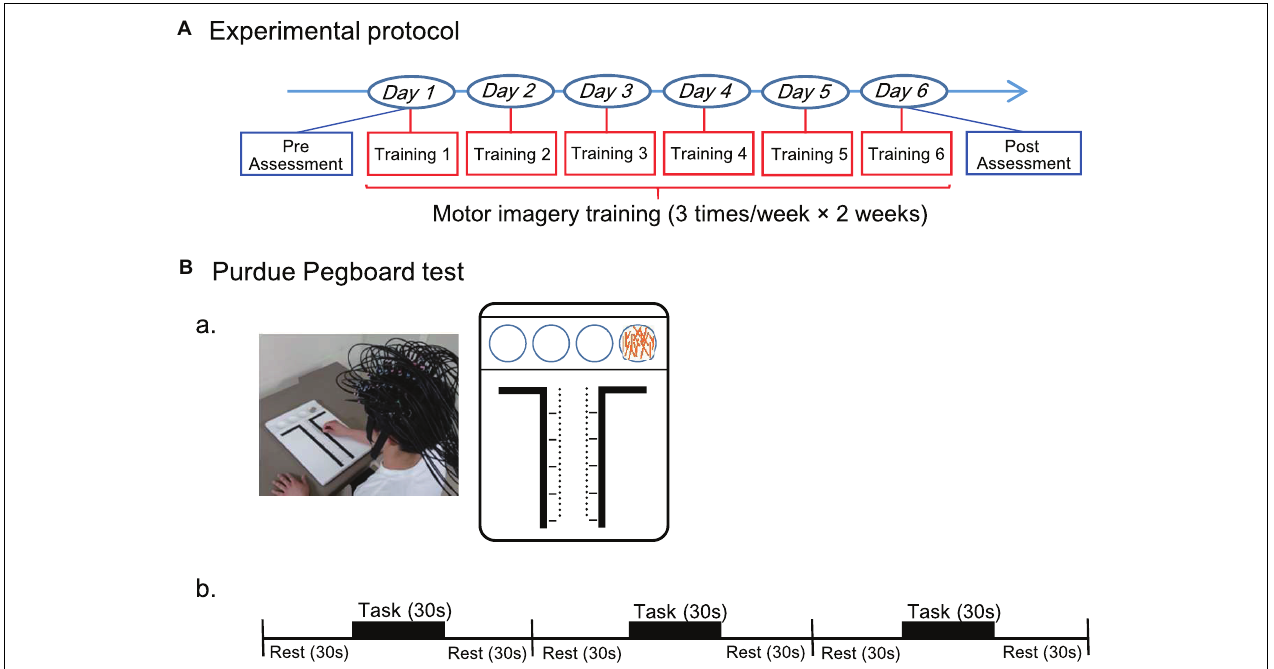
FIGURE 1 | Experimental protocol throughout this study (A) and that for the Purdue Pegboard test (B) . (A) The entire experimental protocol. The experimental protocol composed of three sessions; pre (before training)-assessment session, motor imagery training session, and post (after training)-assessment session. In the motor imagery training session, the subjects received motor imagery training three times a week for 2 weeks. Hand dexterity was assessed using the Purdue Pegboard test in the pre- and post-assessment sessions. (B) The Purdue Pegboard test protocol. (a) A photo of a subject with an fNIRS head cap during Purdue Pegboard testing and schematic illustration of the Purdue Pegboard are shown. The Purdue Pegboard has four cups in the upper side and two rows of 25 holes each arranged vertically in the center of the board. (b) The Purdue Pegboard test consisted of three blocks, and each block had three phases: each phase for 30 s (rest, task, and